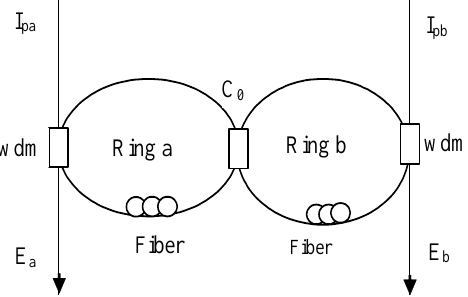
Fig. 1. The transmitter based on a erbium-doped fiber dual-ring laser as “active system”. I pa and I pb are pump light, C 0 coupler, wdm is the wavelength division multiplexer, E a and E b lasing fields output from ring a and ring b,